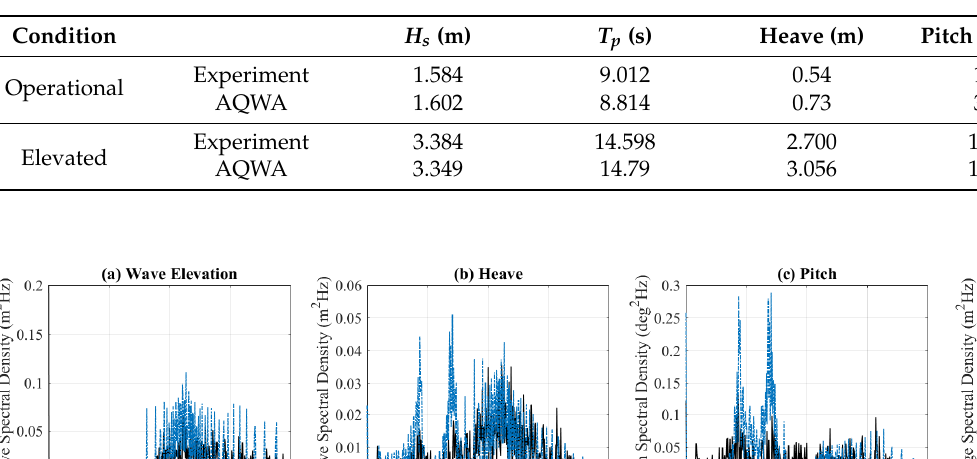
Table 6. Comparison between experimental and numerical results for irregular wave conditions.